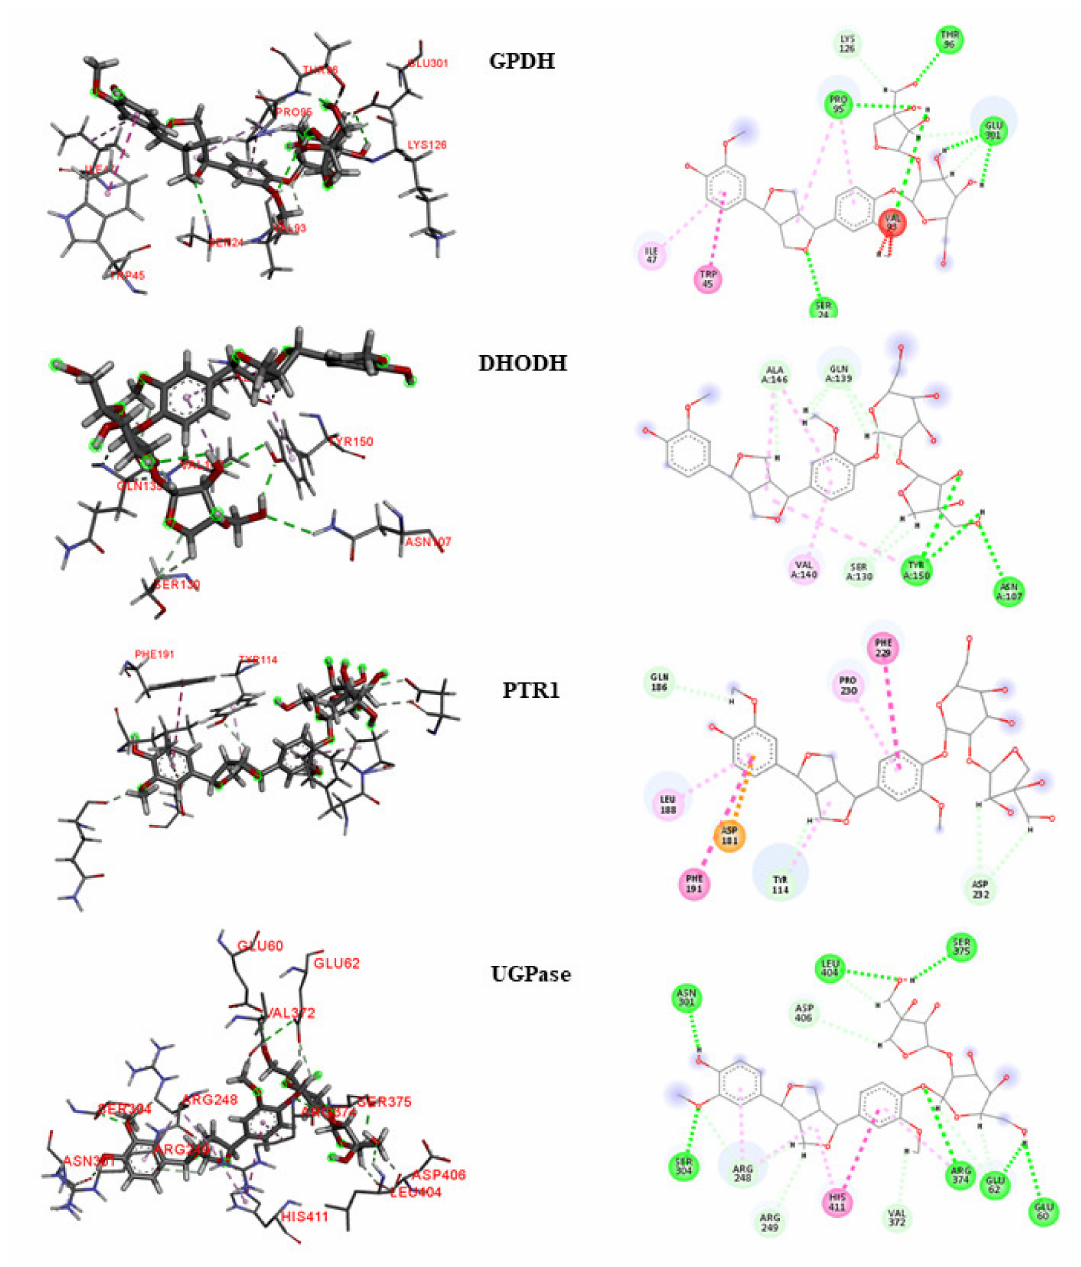
Figure 6. 3D and 2D interactions between lignan 160 and four enzymes [Glycerol-3-phosphate Dehydrogenase (GPDH), Dihydroorotate dehydrogenase (DHODH), Pteridine reductase 1 (PTR1), and UDP—Glucose pyrophosphorylase (UGPase)] in L. braziliensis . Hydrogen bonds are highlighted in green, hydrophobic interactions are highlighted in pink, and electrostatic interactions are highlighted in red.